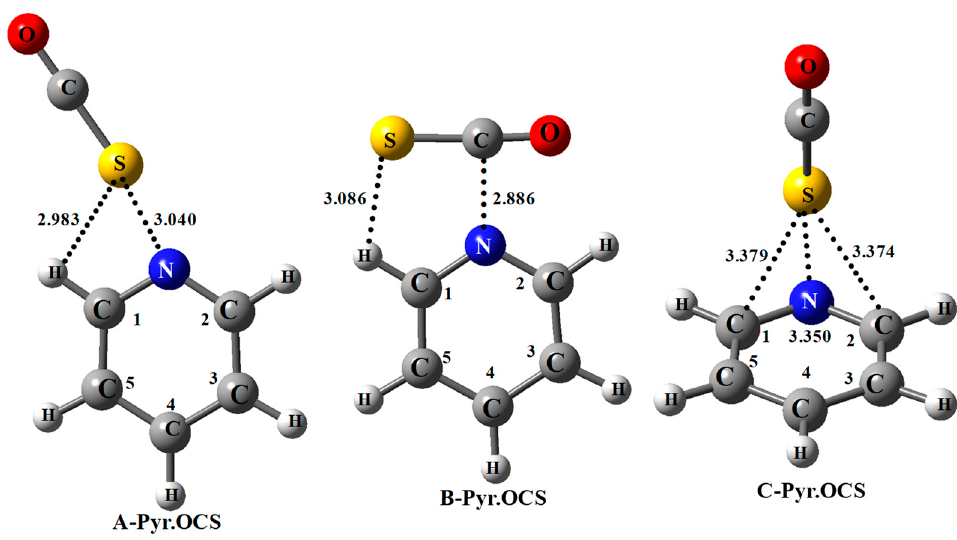
Figure 2. Structures of A , B , and C complexes between para -substituted pyridine with OCS. Bond lengths (in Å) correspond to nonsubstituted pyridine complex.